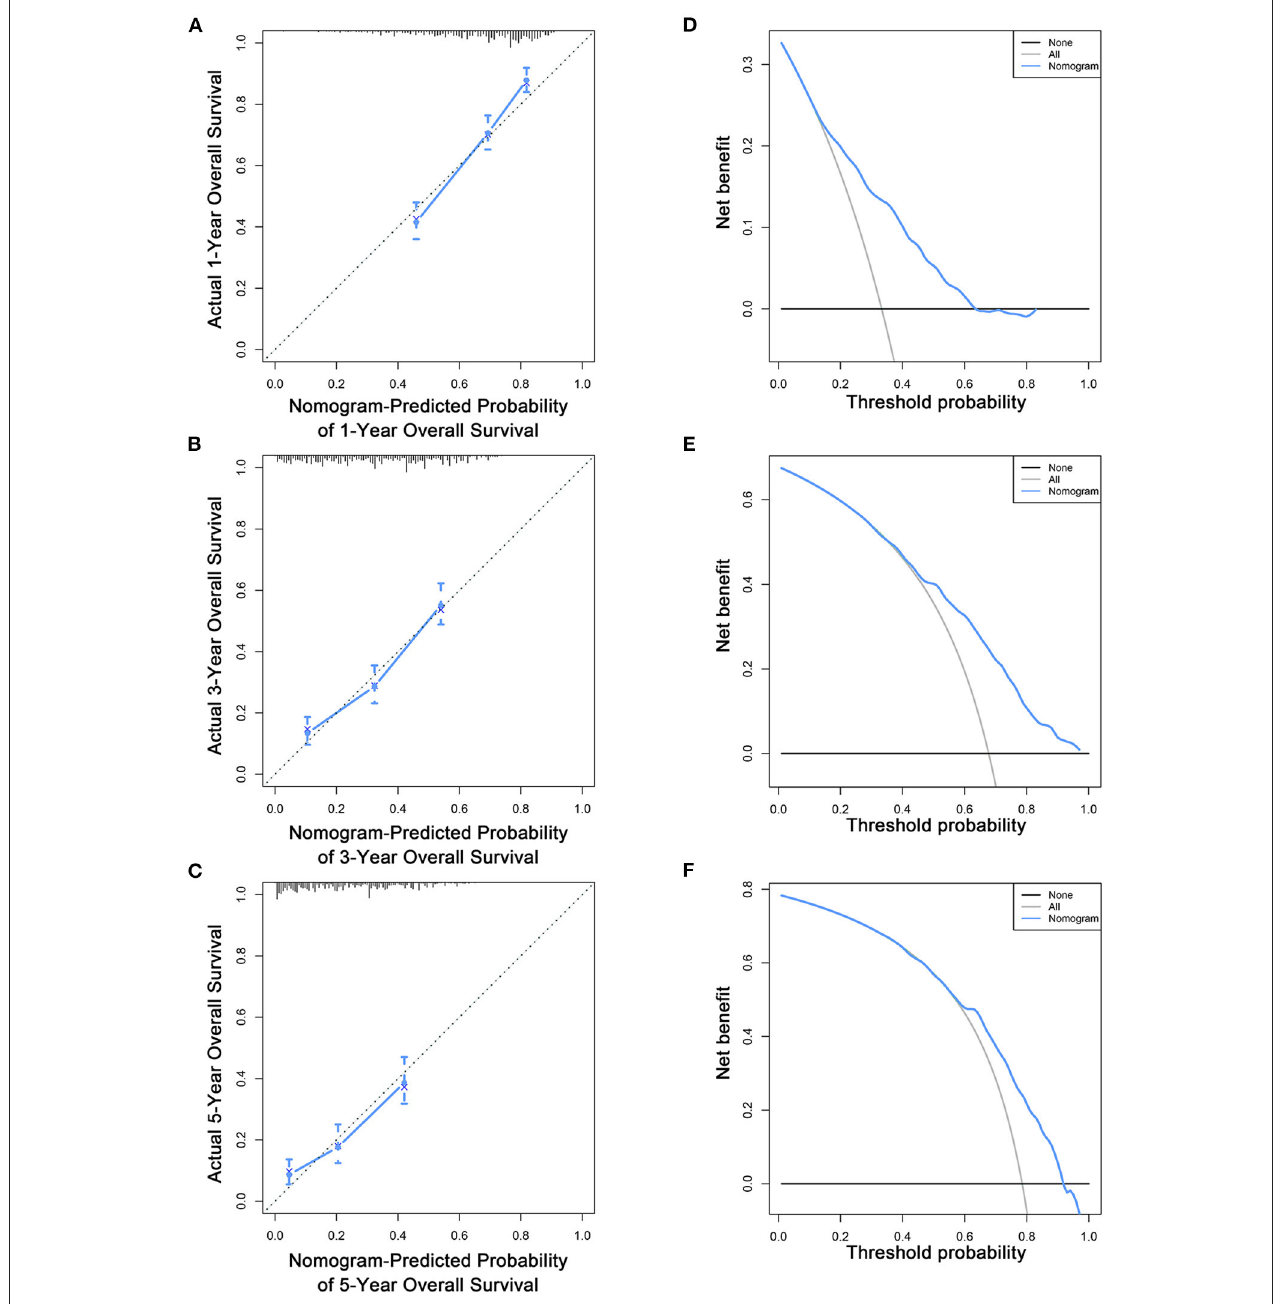
FIGURE 5 | Calibration curves (A–C) and DCA (D–F) of the nomogram for predicting patients’ OS at 1, 3, and 5 years in the training